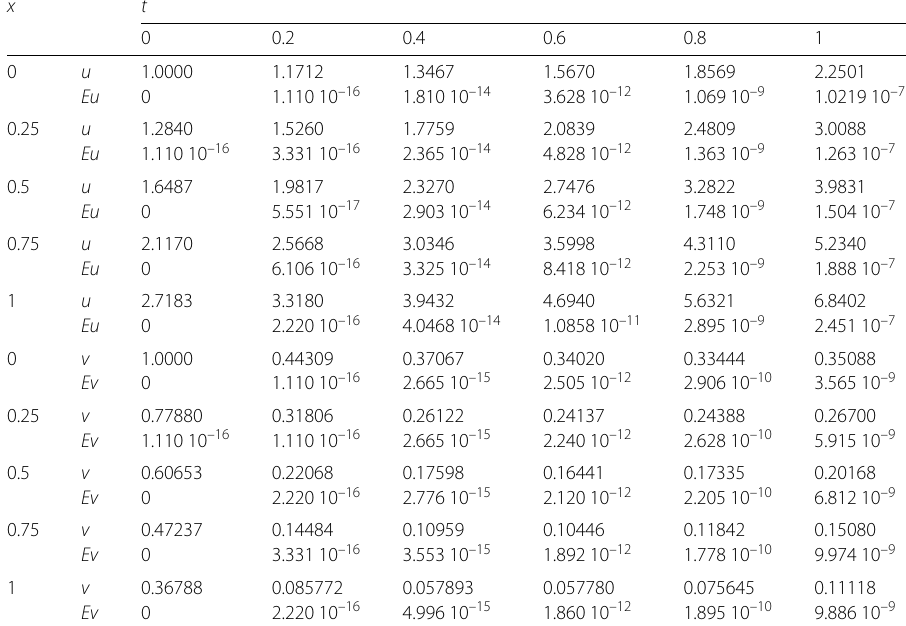
Table 3 Solution and residual error for Example 3 when α = 0.9 and β = 0.3 at several values of x and t using 60 terms of the series ( (cid:2) =